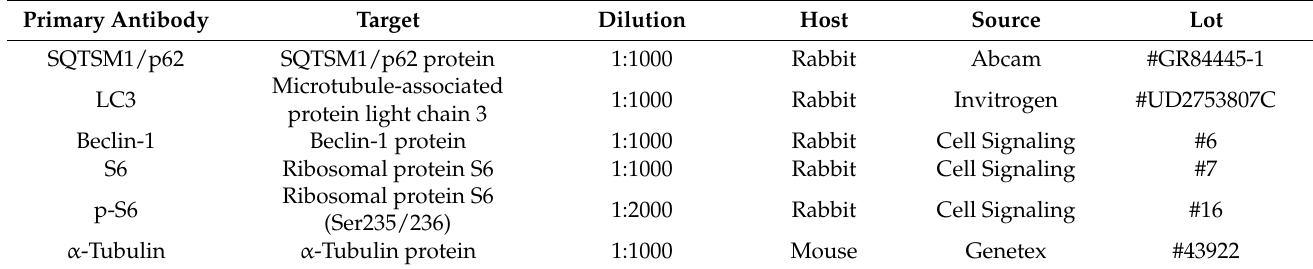
Table 2. Specifications of primary antibodies used in Western blotting